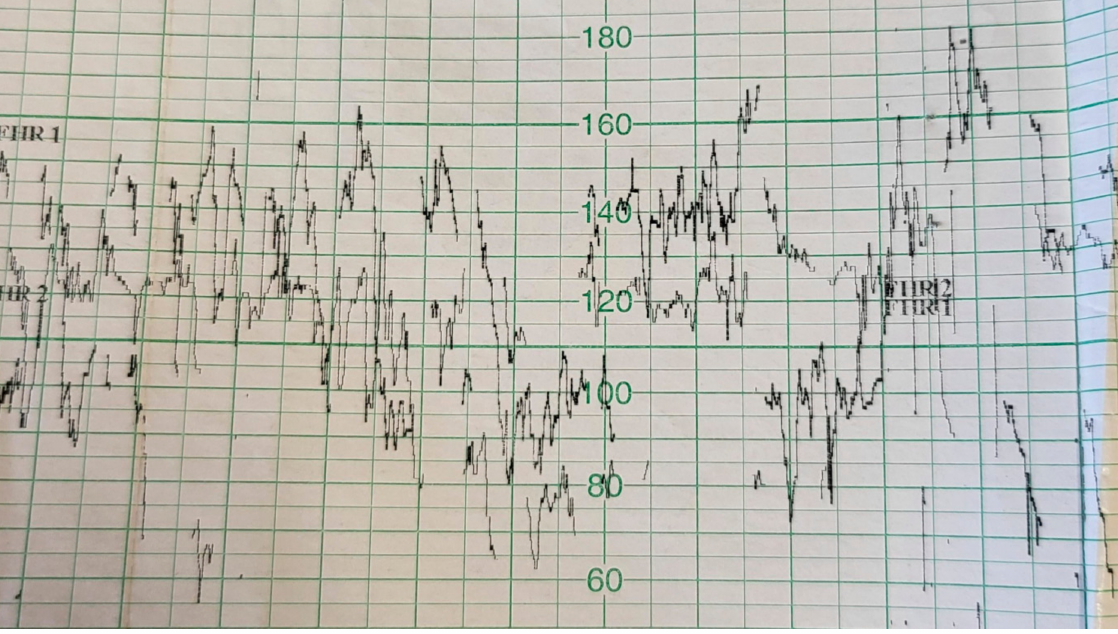
Figure 5. CTG recordings showed prolonged deceleration of both twins, lasting 7 minutes, and a decrease in the heart rate of both fetuses to 80 beats/minute (FIGO consensus guidelines on intrapartum fetal monitoring: Cardiotocography,